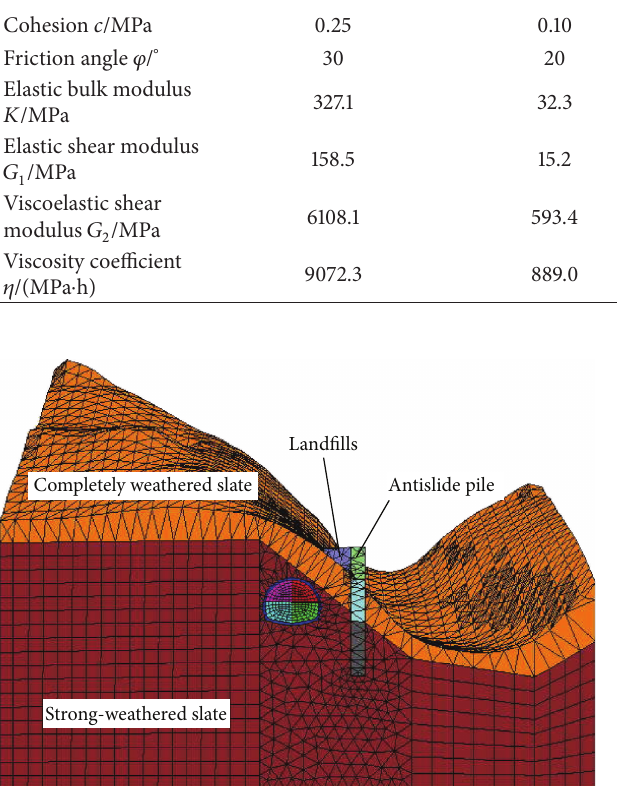
Figure 13: Three-dimensional analysis